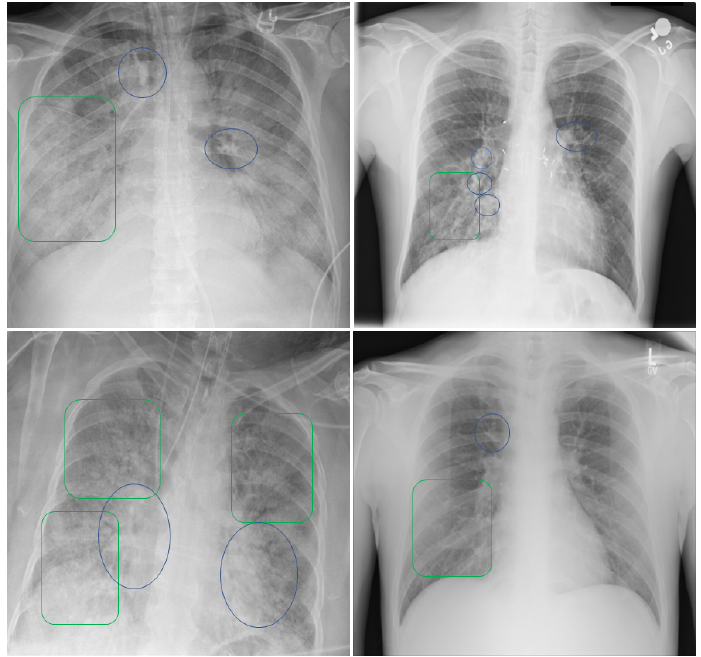
Figure 14. Analysis and diagnosis using patient CXR